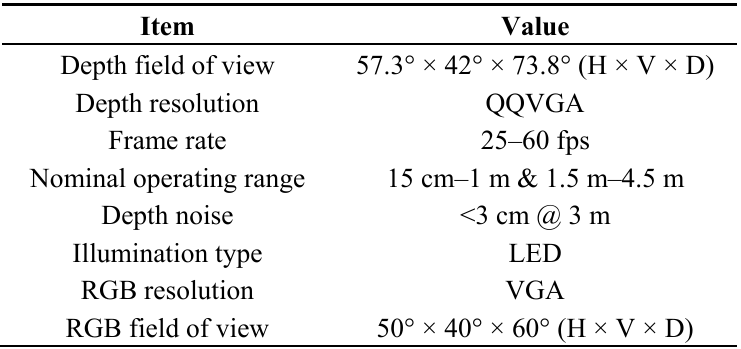
Table 1. Depthsense® 311 (DS311) main